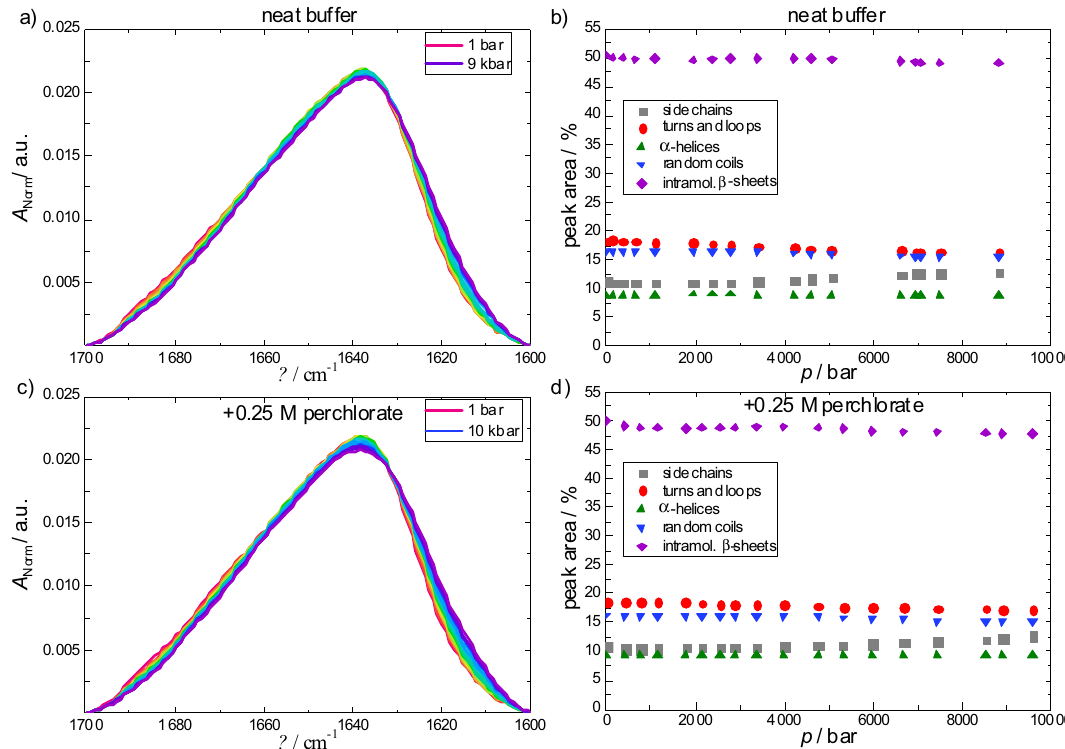
Figure 4. α-Chymotrypsin FTIR spectra. Pressure-dependent changes of the normalized amide I ′ band of α-chymotrypsin (50 mg mL −1 ) ( a ) in neat buffer (Tris buffer + 10 mM CaCl 2 ) and ( c ) + 0.25 M Mg(ClO 4 ) 2 at − 3 °C. ( b , d ) represent the corresponding secondary structural changes obtained from the curve fitting procedure. N =